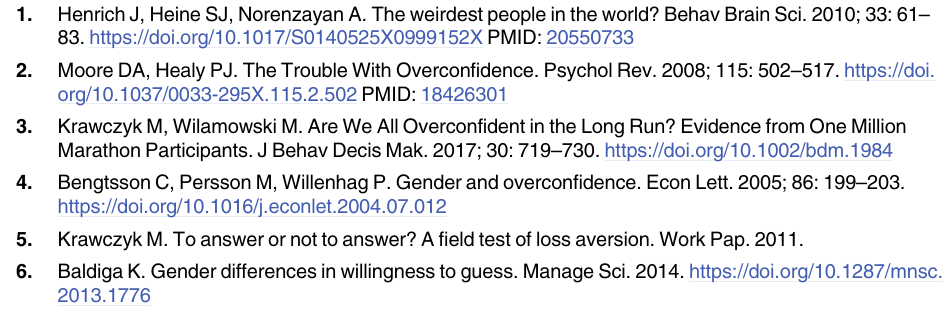
the 21-km split time. A positive male OC could be understood as higher slowdown (OC) in seconds compared to males from the US; likewise, a positive female OC means higher slow- down compared to US females. Country-level gender difference in OC is calculated with the following formula: (US male OC + country male OC)—country female OC. Of course, includ- ing the US male OC and thus US gap (341) in all the national gaps makes no difference for the correlations, as it is a constant. S3 Table. Data sources. a Health and Survival sub-index is not included in our analyses. b for the full list of BIGI variables see [44]. c we use two GDP per capita measures: 1. GDP_per- cap_ppp: GDP per capita, constant prices (purchasing power parity; 2011 international dollar), 2. GDP_percap_nominal: GDP per capita, current prices (US dollars). d Heavy Weapons Index score is not included in our